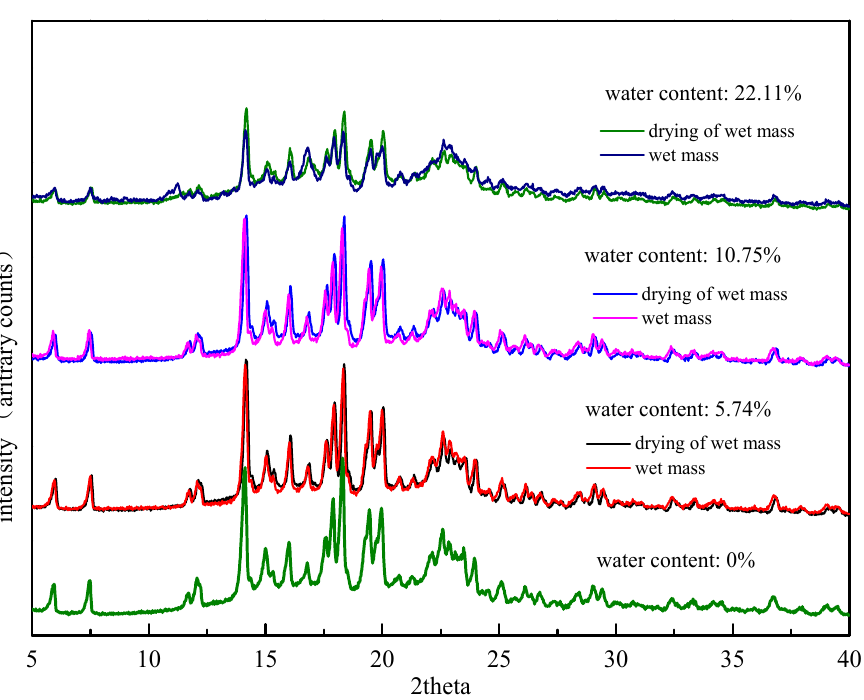
Figure 7. PXRD patterns of formulation wet mass with different water contents before and after drying at 60 °C.